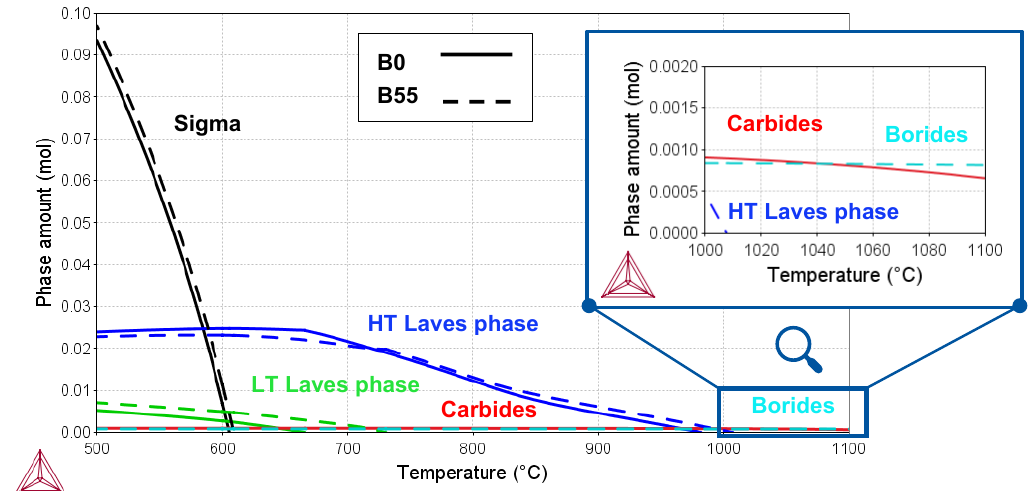
Figure 2. Results of the thermodynamic equilibrium calculation of phase amount in the investigated reference B0 and the boron-alloyed B55 alloy (ThermoCalc, database TCFE8).